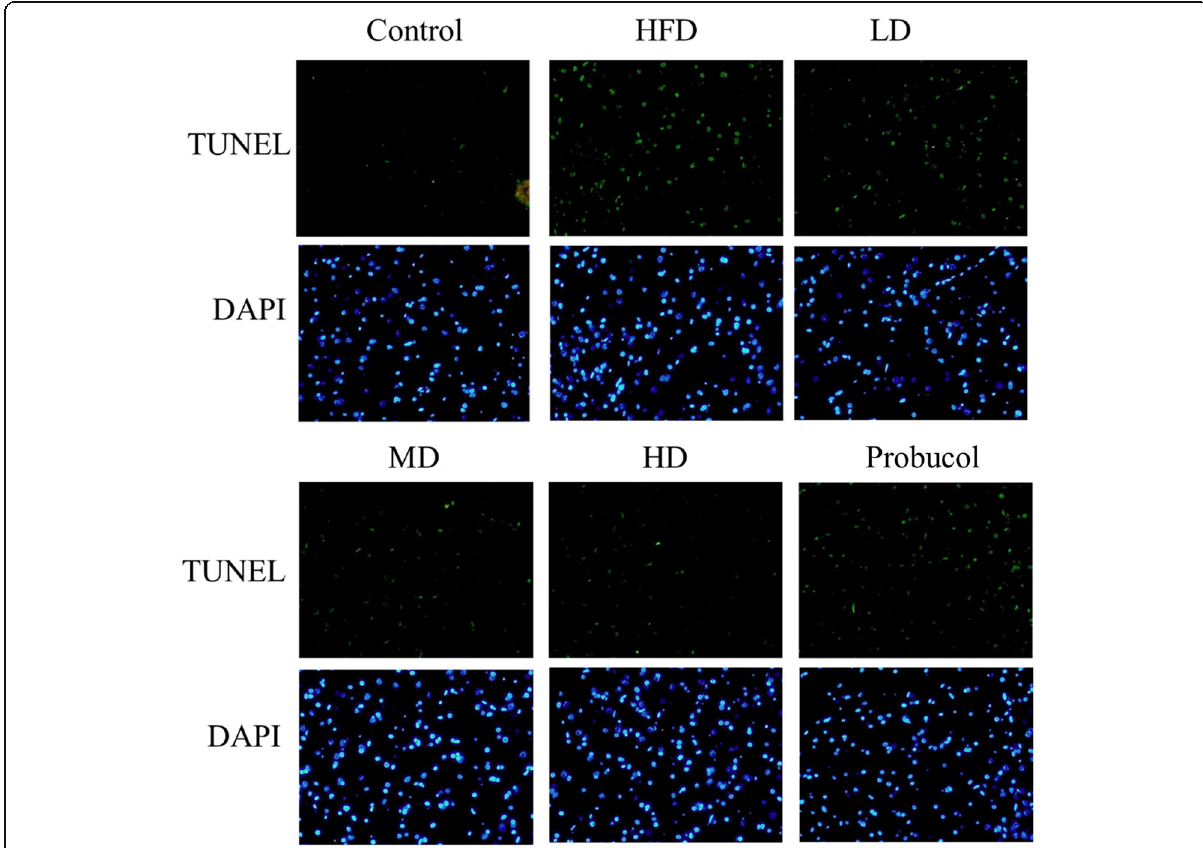
Fig. 1 Effect of APPH on hepatic apoptosis. TUNEL assay results show apoptotic nuclei (green) among the total nuclei (blue) in Control hamsters, HFD fed hamsters (HFD), HFD fed hamsters treated with low dose of APPH (L-APPH), HFD fed hamsters treated with moderate dose of APPH (M- APPH), HFD fed hamsters treated with high dose of APPH (H-APPH) and HFD fed hamsters treated with